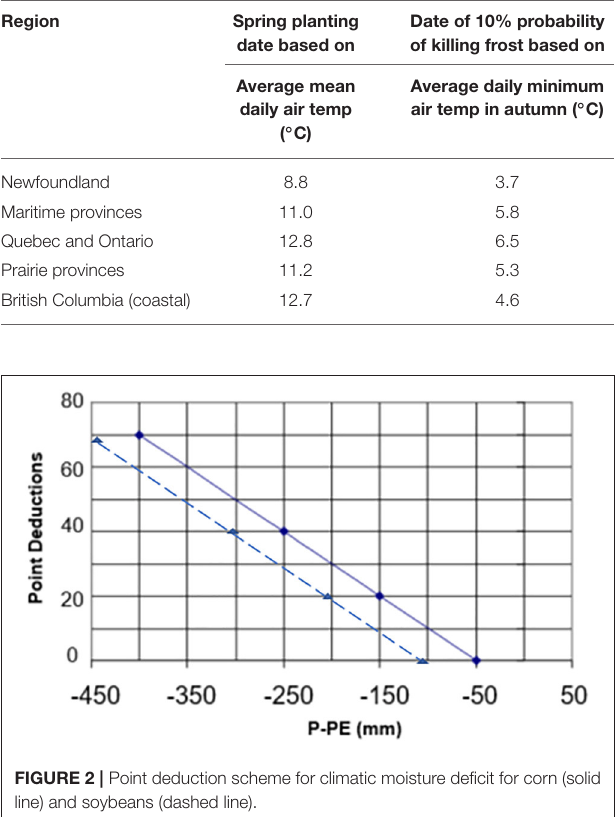
FIGURE 2 | Point deduction scheme for climatic moisture deficit for corn (solid line) and soybeans (dashed